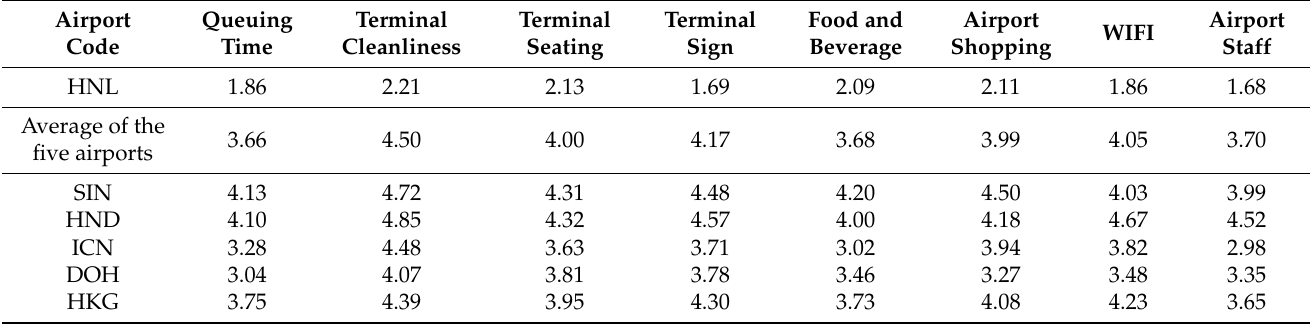
Table 5. Attribute Ratings of the Honolulu International Airport and the World’s Leading